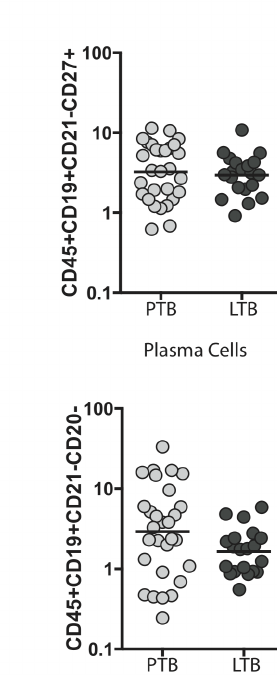
Figure 5. The distribution of B cells subsets in TB infection and disease. Ex vivo phenotyping of B cell subsets was performed on PTB and LTB individuals by flow cytometry. B cells were classifed as naı¨ve B cells (CD45 + CD19 + CD21 + CD27 2 ); classical memory B cells (CD45 + CD19 + CD21 + CD27 + ); activated memory B cells (CD45 + CD19 + CD21 2 CD27 + ); atypical memory B cells (CD45 + CD19 + CD21 2 CD27 2 ); immature B cells (CD45 + CD19 + CD21 + CD10 + ) and plasma cells (CD45 + CD19 + CD21 2 CD20 2 ). P values were calculated using Mann-Whitney U